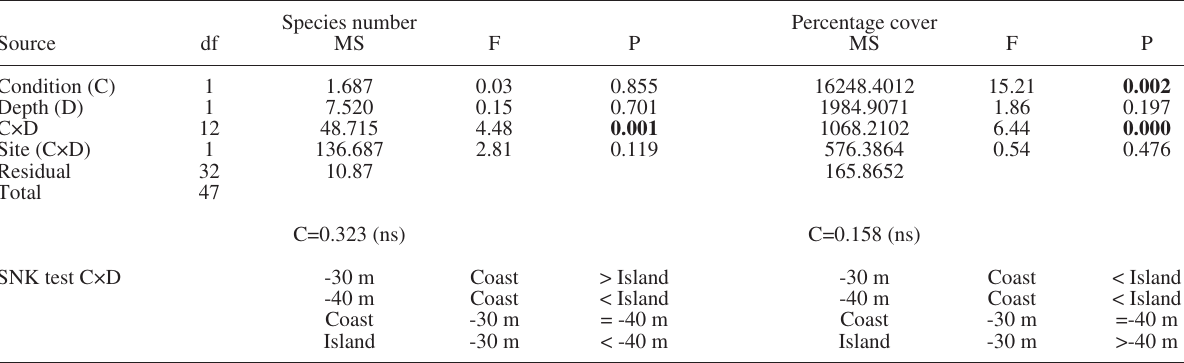
Table 3. – Results of ANOVA analyses on species number and total percentage cover. Significant results are in bold.